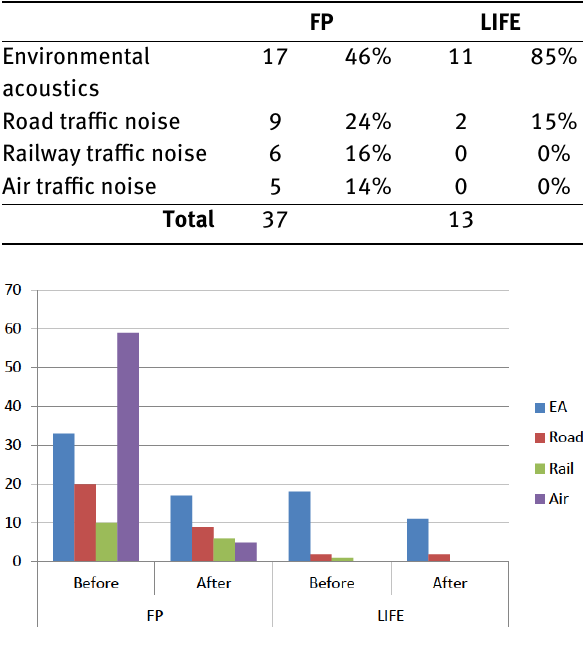
Figure 3: Comparison of projects, according to research topic, be- fore and after the selection